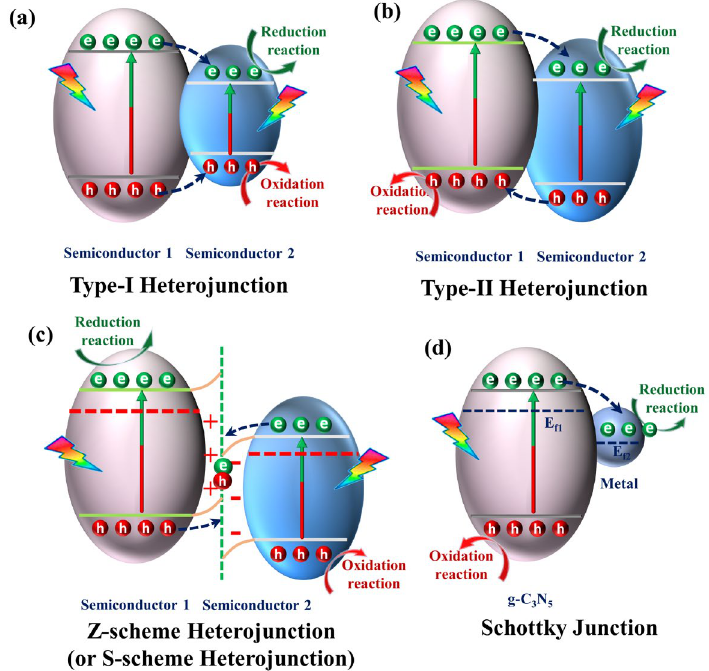
Figure 10. Schematic illustration of photoinduced carrier transfer on different heterojunctions: ( a ) type-I heterostructure; ( b ) type-II heterostructure; ( c ) Z-scheme heterostructure or S-scheme heterostructure; ( d ) Schottky junction.